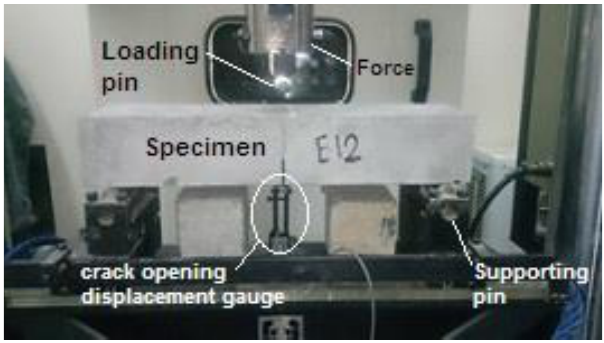
Figure 3. Adjustment of the device and specimen to measure the load – CMOD.